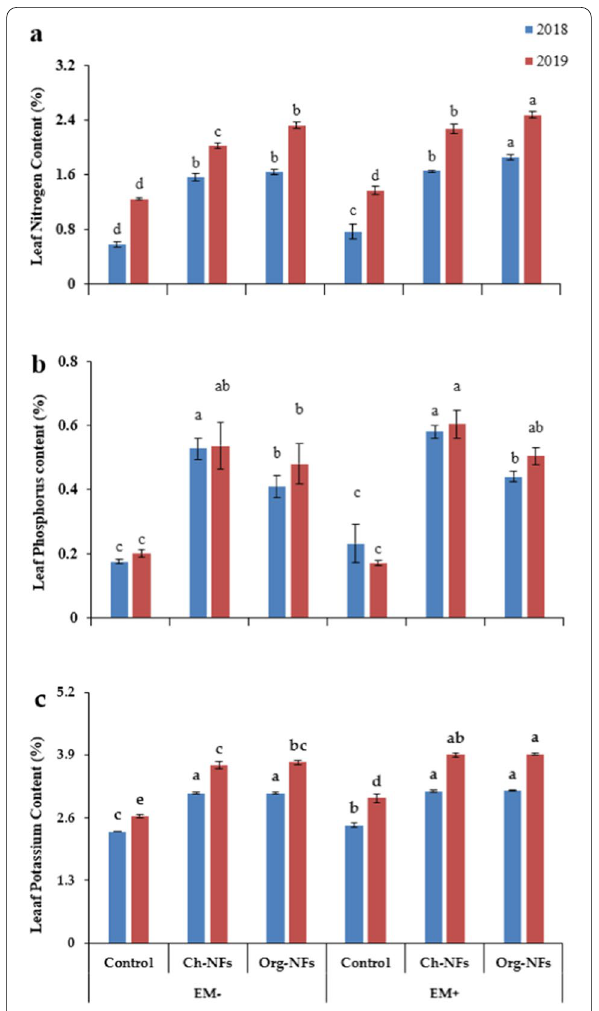
Fig. 2 Effect of nitrogenous fertilizers and effective microorganisms on leaf nitrogen ( a ), phosphorus ( b ) and potassium ( c ) of stevia during two growing seasons (2018–19). Ch - N chemical nitrogenous fertilizer, Org-N organic nitrogenous fertilizer, EM effective microorganisms. Each value expressed in figure is mean of two cuttings. Vertical bars indicate mean standard deviation. ± Means followed by the same letter within the same series are not significantly different according to Fisher’s least significant difference (LSD) technique (p 0.05) ≤